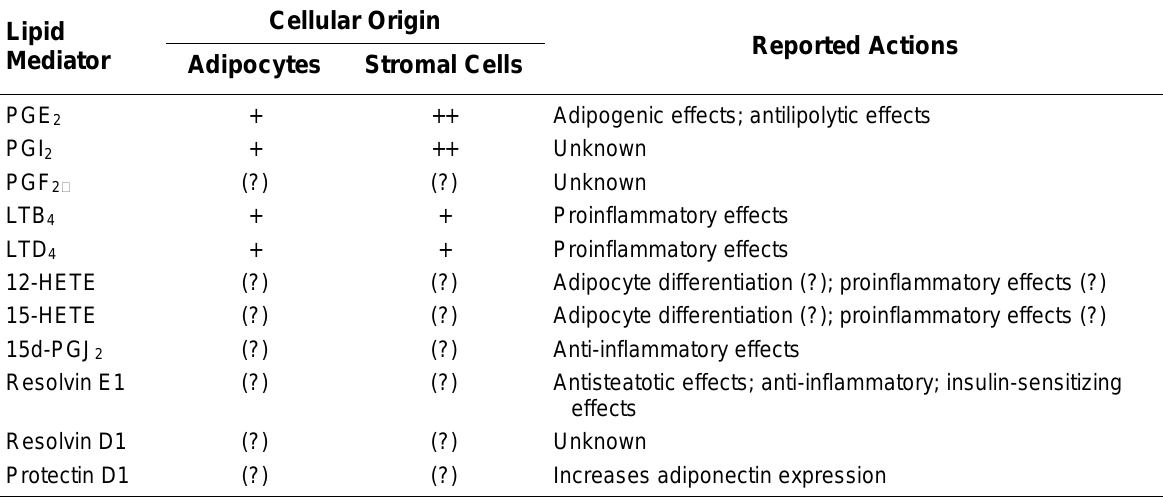
List of Selected ω -6 PUFA – and ω -3 PUFA – Derived Lipid Mediators Produced by Adipose Tissue